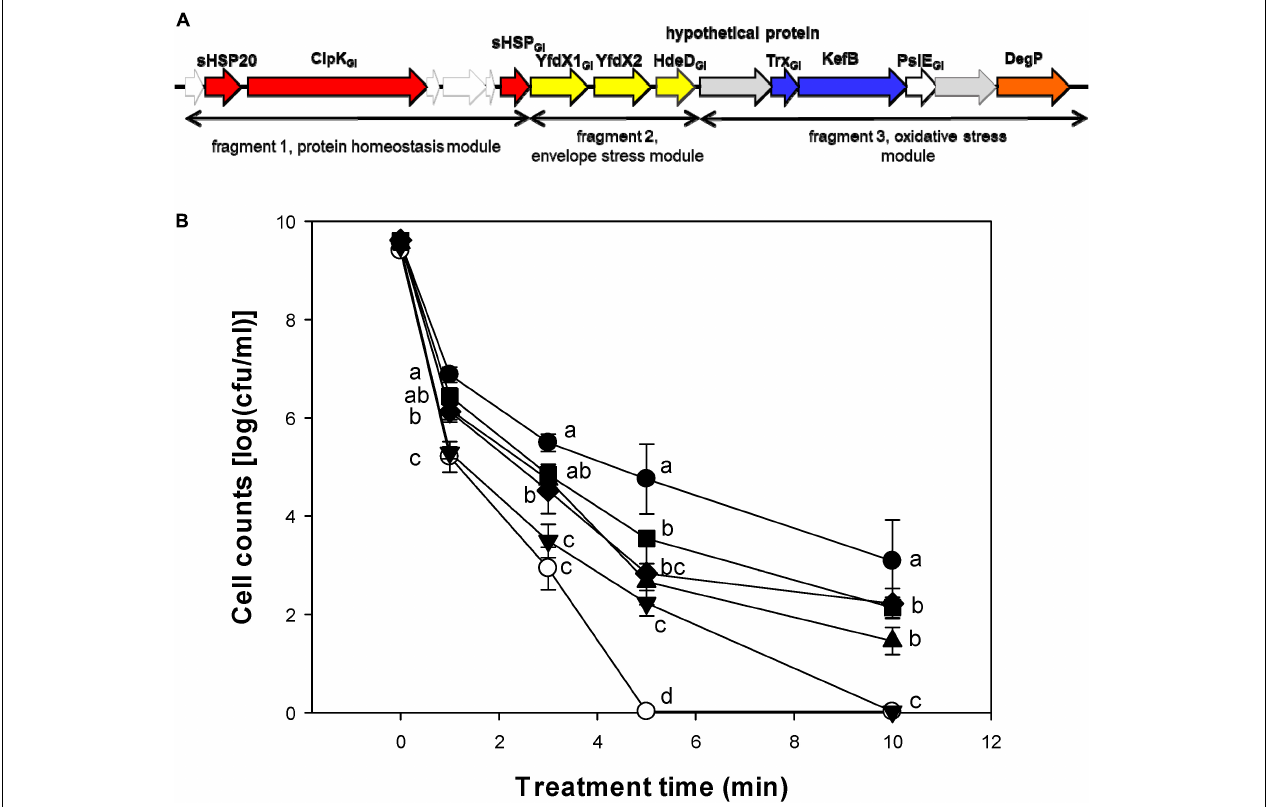
FIGURE 6 | Contribution of the locus of heat resistance (LHR) or parts of the LHR to pressure resistance of E. coli 1655 ibpA-yfp . (A) Schematic representation of the LHR1. Only genes that are expressed in E. coli MG1655 are indicated. Proteins are color coded based on their predicted function: red, heat shock proteins; yellow, hypothetical proteins with a possible relationship to envelope stress; blue, genes related to oxidative stress; orange, DegP with possible relationship to signaling in the Cpx, EvgA and σ E pathways. Genes carry the footnote “GI” for genomic island if an ortholog of the same gene is present in genomes of E. coli . The three fragments of the LHR that were cloned are indicated. (B) Pressure resistance of E. coli MG1655 ibpA-yfp carrying pRK767 ( ) or the derivatives of this vector with the full length LHR ( • ), the LHR fragment F1 ( (cid:78) ), F2 ( (cid:72) ), F3 ( (cid:7) ), or F1-2 ( (cid:4) ). Cells were treated at 400 MPa and 20 ◦ C for 1–10 min. Data are shown as means ± standard deviation of triplicate independent experiments. Significant differences between cell counts were determined with one way ANOVA and the Holm-Sidak post hoc analysis; values with different superscripts are significantly different ( p <